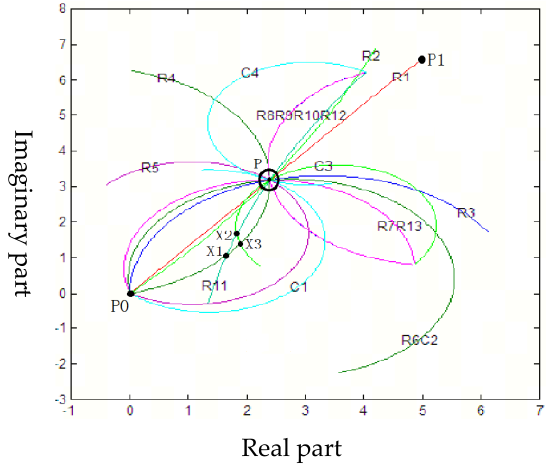
Figure 4. Sketch map of fuzzy groups.